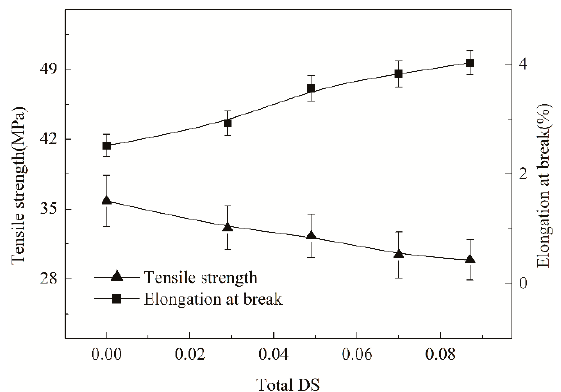
Figure 7. Impact of hydroxypropylsulfonation/caproylation on tensile strength and elongation at break of ACS films.